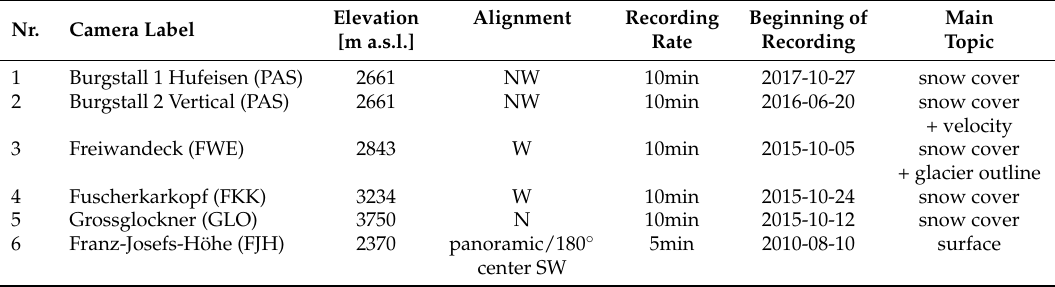
Table 5. Automatic cameras. Location of cameras are indicated in Figure 1. Cameras 1–5 are